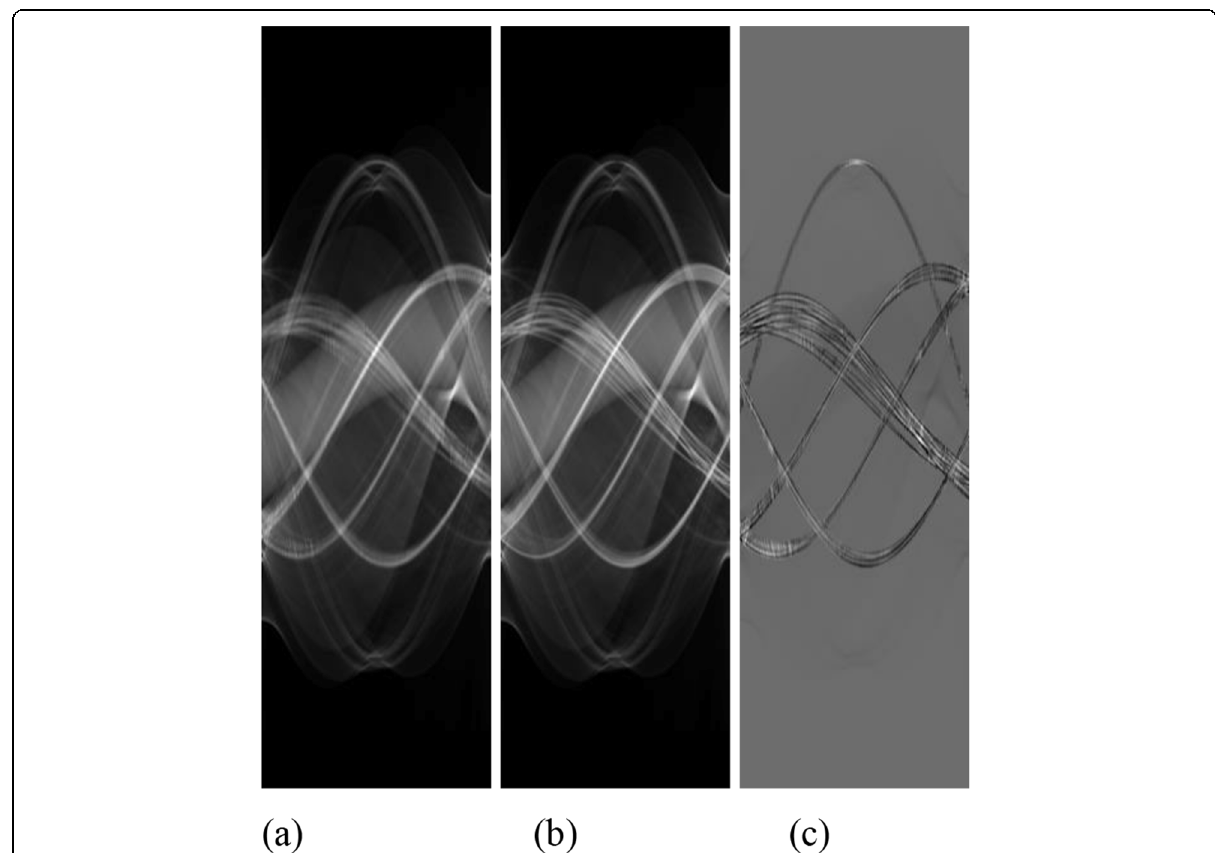
Fig. 8 Sinograms of bag #1. a Processed with β 1 = 0.004 and β 2 = 5; b Raw; c